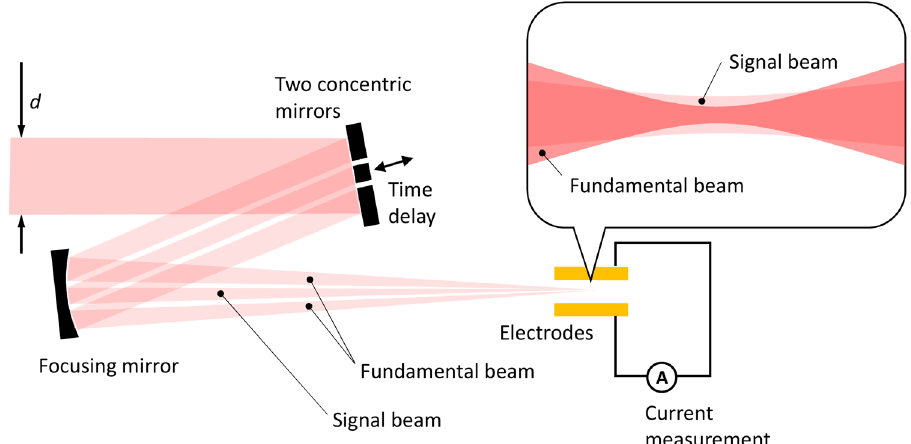
Figure 3. Experimental setup for the TIPTOE measurement. An incident laser beam with a diameter of d was reflected using two concentric mirrors. Both beams were focused using a focusing mirror. The outer beam is the fundamental beam that makes a relatively small and intense beam at the focus. The inner beam is the signal beam that makes a relatively big and weak beam at the focus. The ionization yield was measured using the transimpedance amplifier attached to the metal